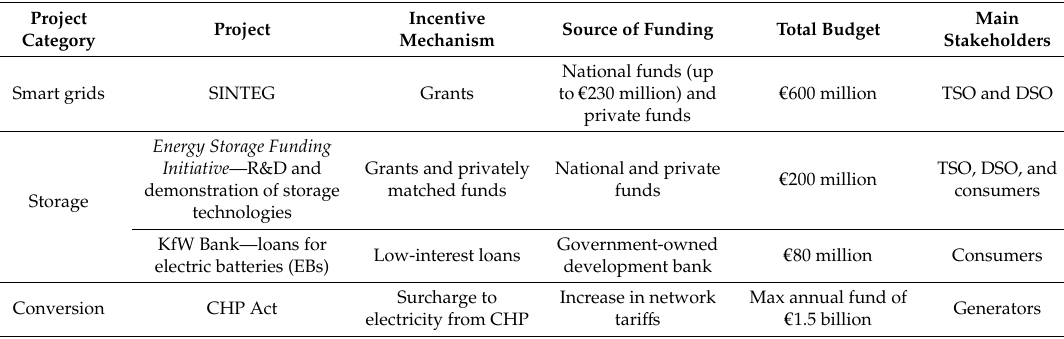
Table 2. Overview of network innovation projects in